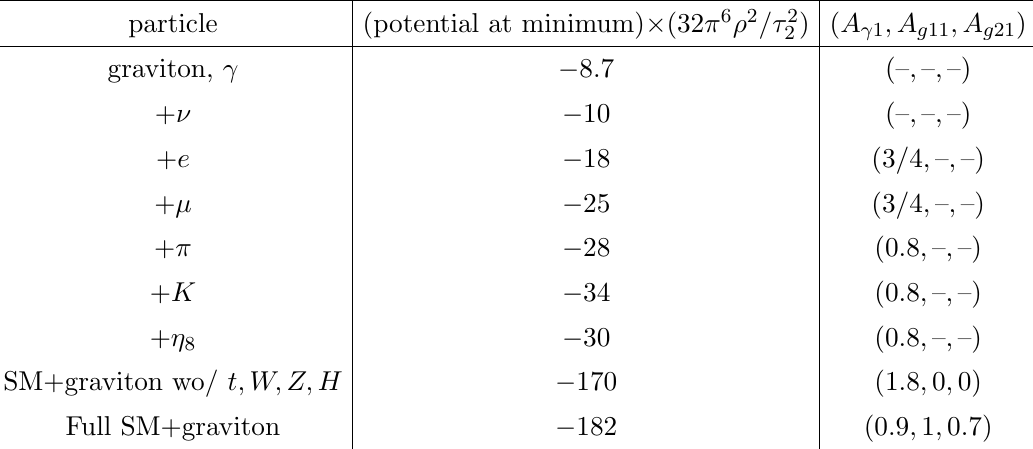
Table 7 . Same as (cid:12)gure 4, but for z = 1 = 2, Dirac neutrinos.